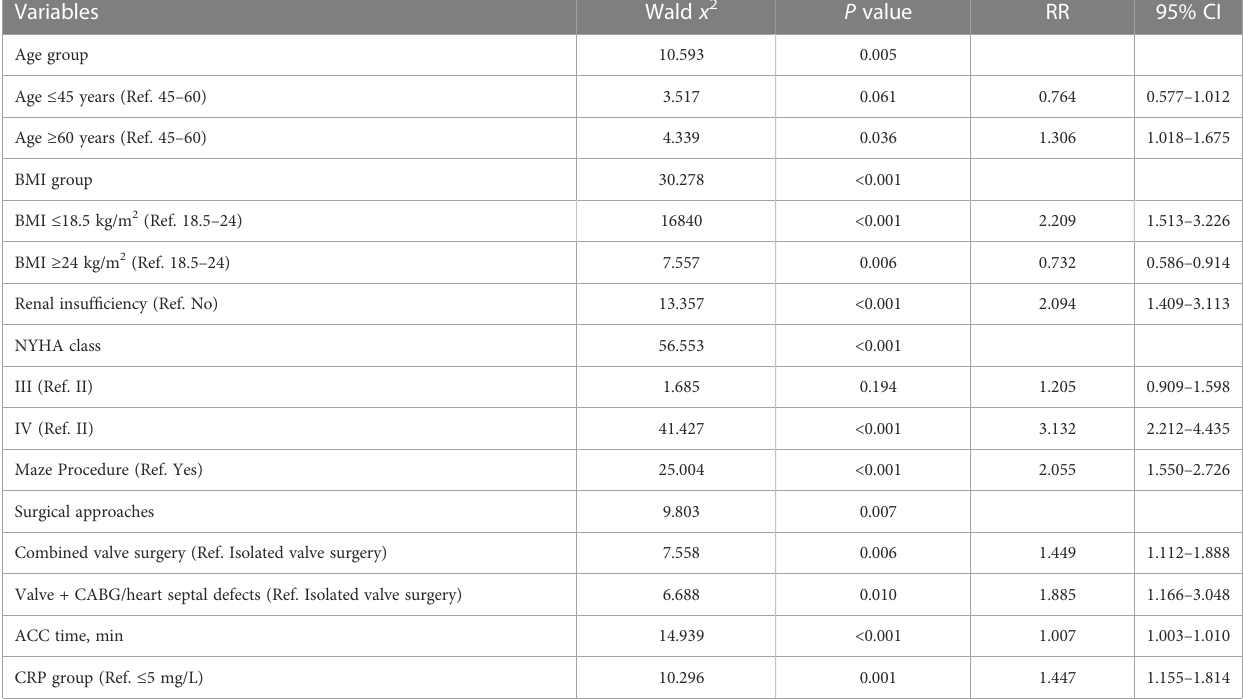
TABLE 3 Multivariable logistic regression analysis for postoperative BNP >400